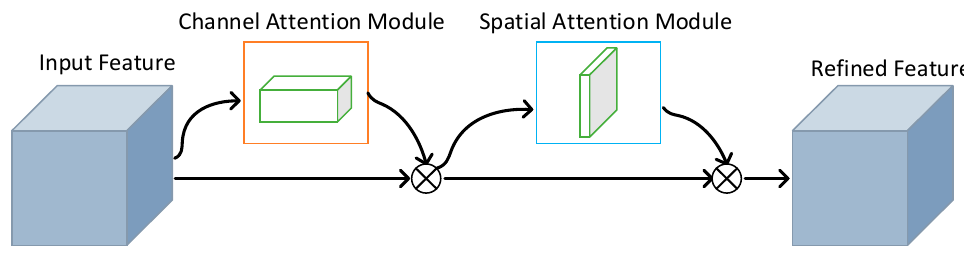
Figure 5. CBAM structure diagram.